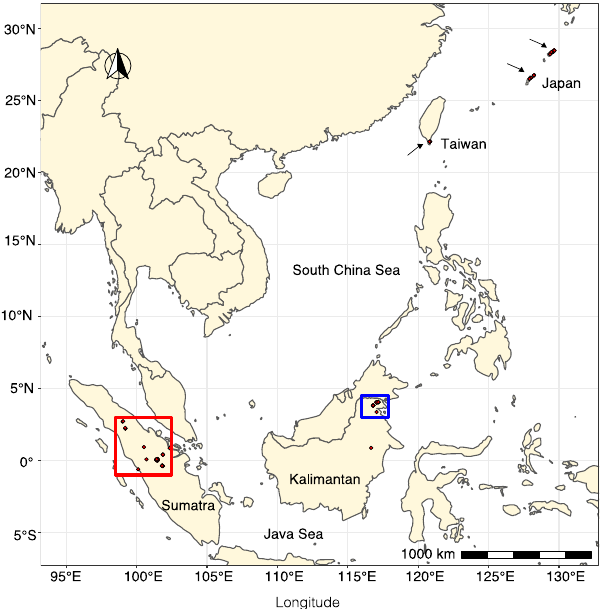
Figure 6. Map of Southeast and East Asia showing the sampling locations in Indonesia, Taiwan, and the Japanese Okinawa and Amami islands (indicated by red dots and arrows) where “ P. palustris” isolates were collected.